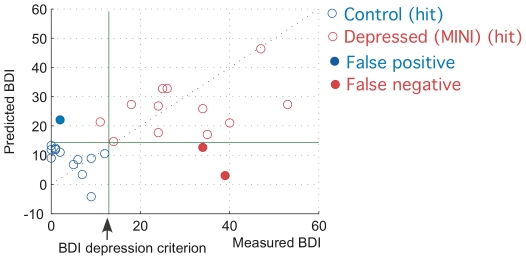
Model Performance.The predicted BDI-II (Y-axis) vs. the measured BDI-II (X-axis). Coefficient of correlation between predicted and measured BDI-II scores was r = 0.55.